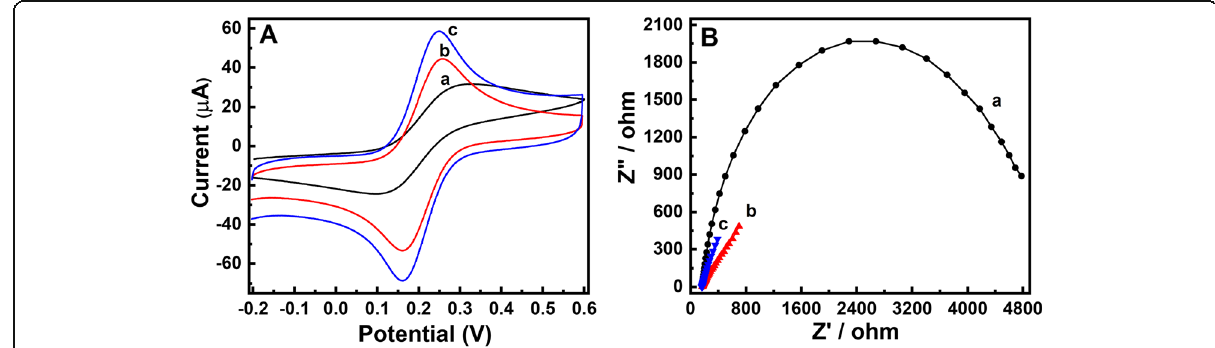
Fig. 3 a CV and b EIS of a GCE - PPy, b GCE - ErGO/PPy, and c GCE - ErGO/MWCNT/PPy in 5 mM K 3 Fe(CN) 6 containing 0.1 M KCl. CV scan rate: 50 mVs − 1 ; impedance frequency range: 100 KHz to 0.1